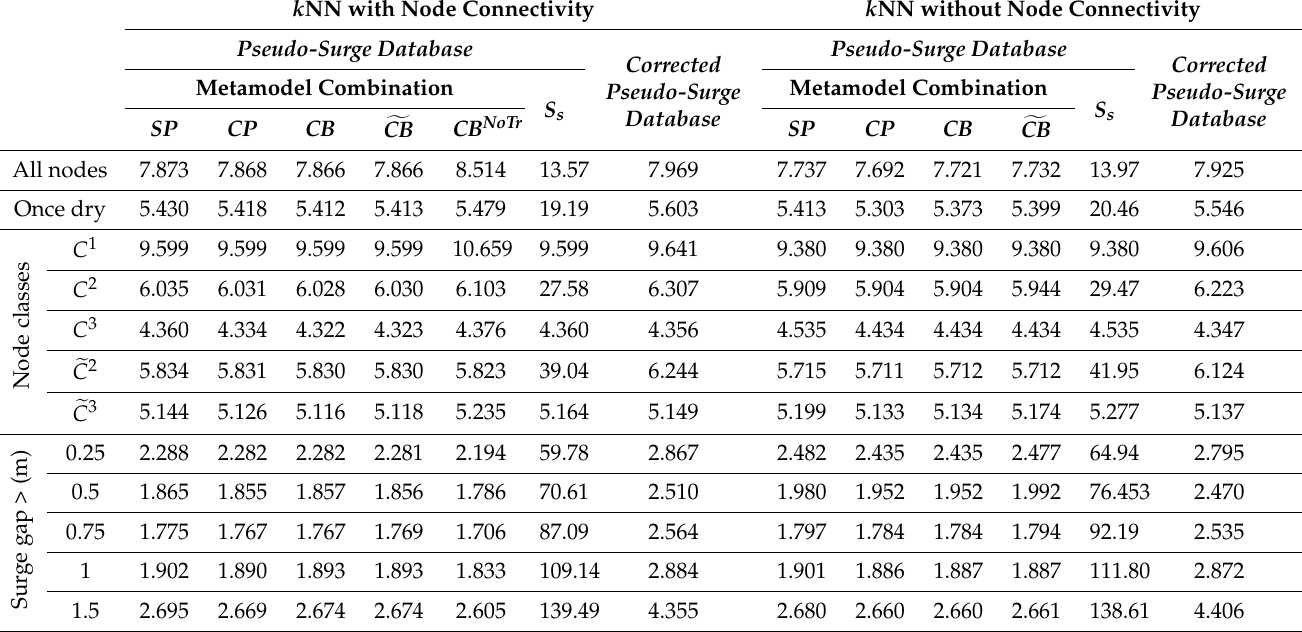
Table 3. Surge score SC (cm) averaged across different groups of nodes for different surrogate model